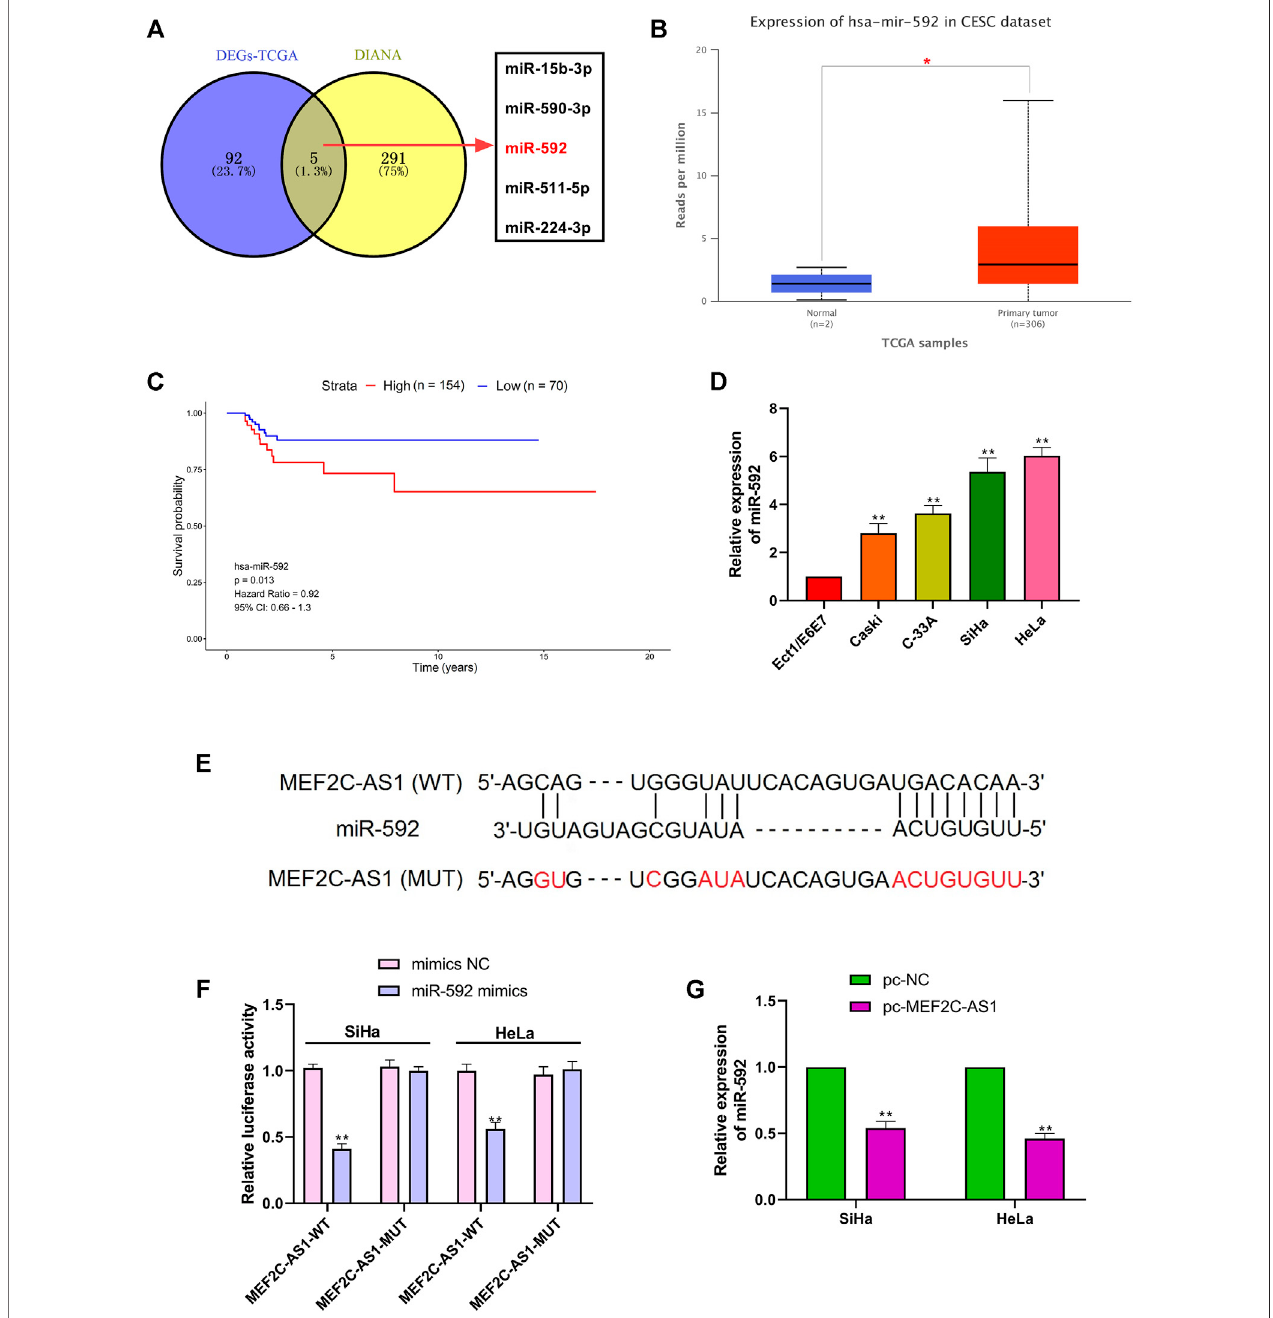
FIGURE 3 | LncRNA MEF2C-AS1 was the target of miR-592. (A) The potential miRNAs that may bind to lncRNA MEF2C-AS1 was predicted by searching the DIANA tools and the differentially expressed miRNAs screened from TCGA database; (B) TCGA data showed the expression changes of miR-592 in CESC tissues; (C) Kaplan-Meier survivalcurvefromTCGAdescribedtheoverallsurvival; (D) qRT-PCRwasperformed todetect themiR-592expression incervical cancercelllines(Caski, C-33A, SiHa, and HeLa) and normal cervical cell (Ect1/E6E7); (E) DIANA tool predicts the binding sites between lncRNA MEF2C-AS1 and miR-592; (F) luciferase activity of MEF2C-AS1-wt, MEF2C-AS1-mut upon the transfection of miR-592 mimics or mimics NC was evaluated by luciferase reporter assay; (G) The mRNA expression of miR-592 was detected in SiHa and HeLa cells by qRT-PCR after transfection with pc-MEF2C-AS1. * p < 0.05, compared with normal tissues (B) ; ** p < 0.01, compared with Ect1/E6E7 group (D) ; ** p < 0.01, compared with mimics NC group (F) ; ** p < 0.01, compared with pc-NC group (G) .